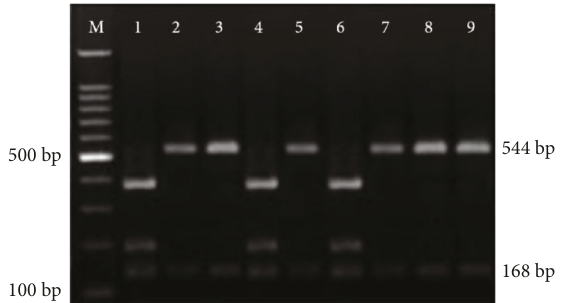
Figure 2: Agarose gel electrophoresis of MseI restriction enszyme digestion of Toxoplasma gondii GRA6 gene nested PCR amplifi- cation products. M: 100 bp molecular weight marker. Lanes 2, 3, 5, 7, 8, and 9: samples coinciding with type I (cutting bands at 168, 544bp). Lanes 1, 4, and 6: atypical digestion